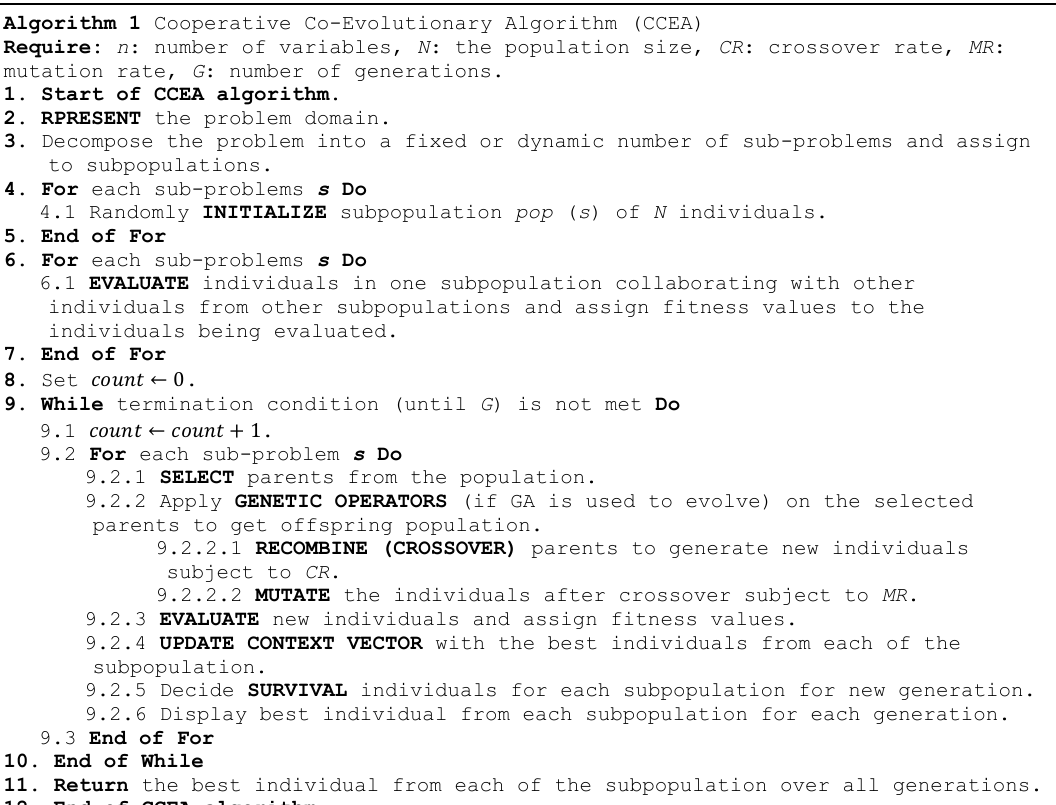
Algorithm 1 Cooperative Co-Evolutionary Algorithm (CCEA) Require: n : number of variables, N : the population size, CR : crossover rate, MR : mutation rate, G : number of generations. 1. Start of CCEA